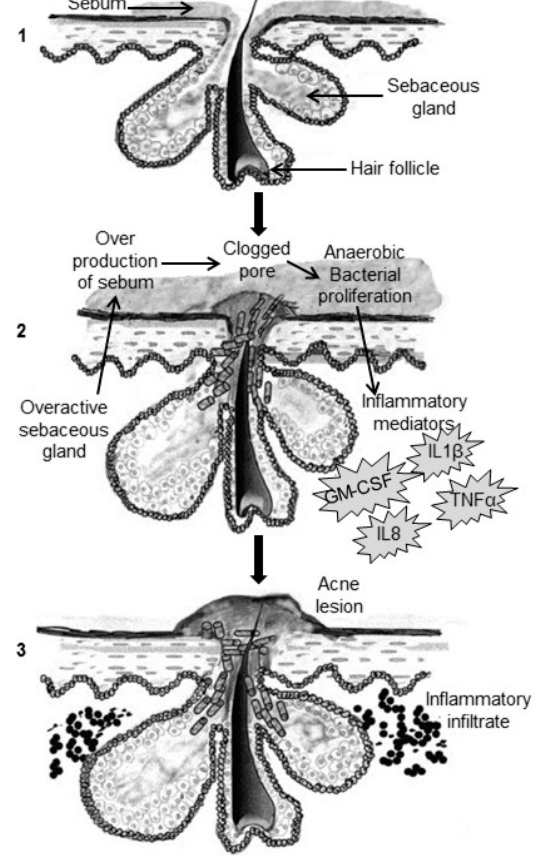
Figure 1. Pathogenic factors contributing to the development of acne: (1) The normal pilosebaceous unit. (2) The clogging of the pore is aggravated by hyperkeratinization and excess sebum production whilst anaerobic bacteria (mainly P. acnes ) proliferate and inflammatory mediators are released.